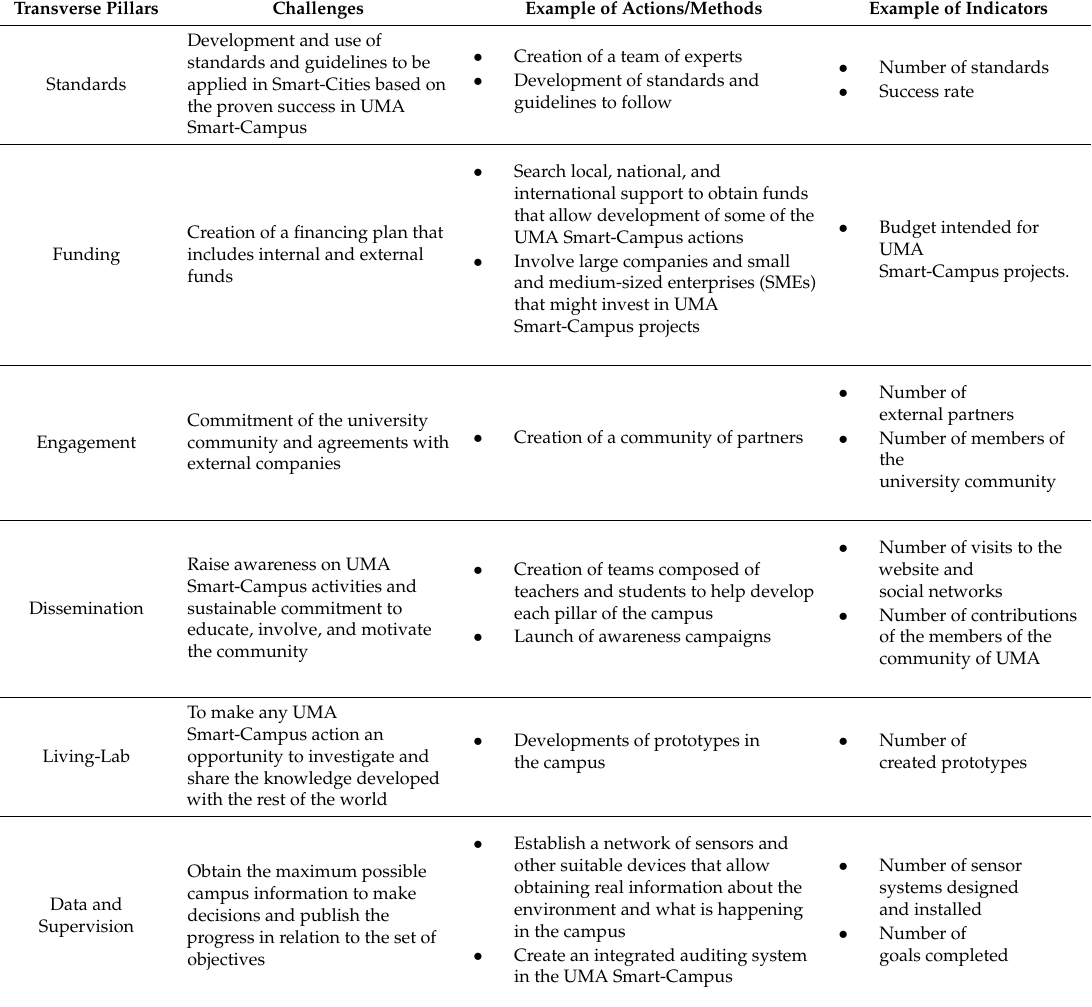
Table 1. Transverse pillars, challenges, actions/methods, and